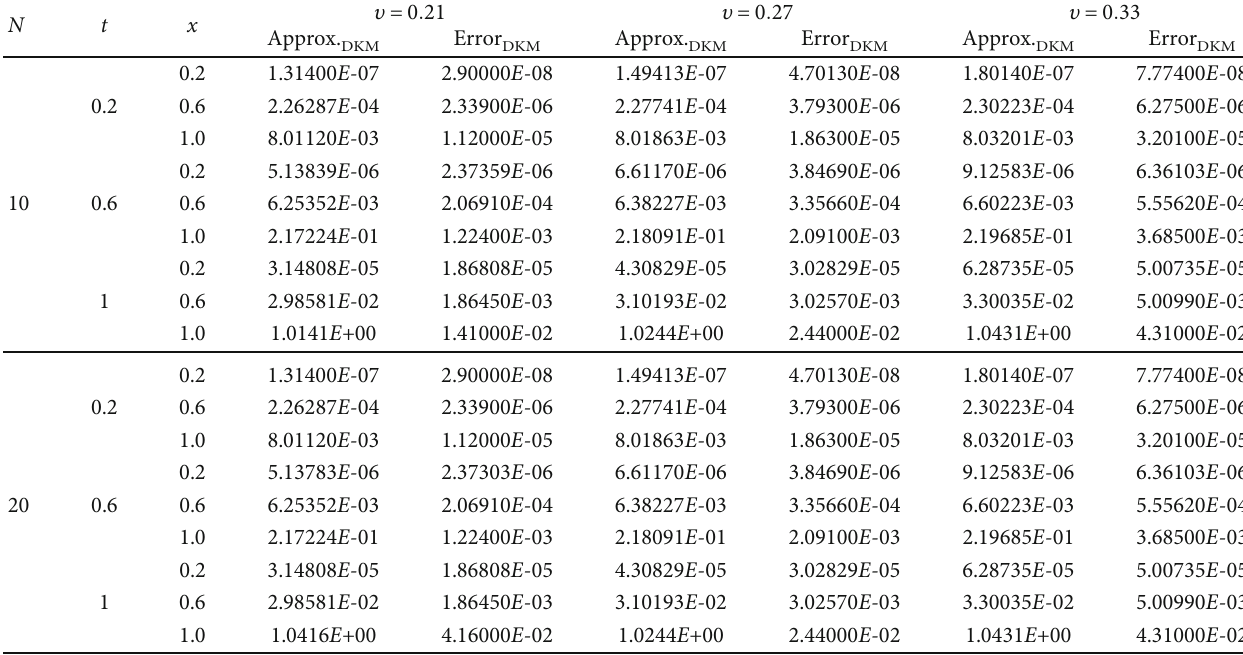
Table 3: The approximate values and the absolute relative error values using DKM for linear case ( k = 1 ).